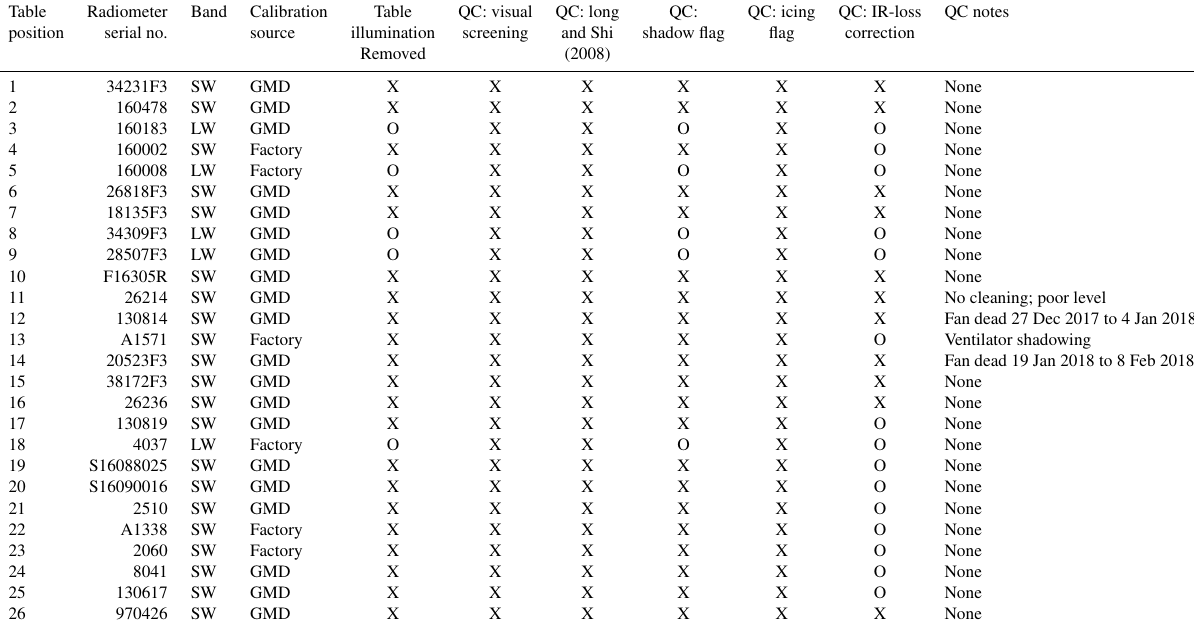
Table 1. List of quality control procedures received by D-ICE instruments. An “X” denotes that the procedure was implemented and “O” indicates that the procedure was not implemented. Table Radiometer Band Calibration Table QC: visual QC: long QC: QC: icing QC: IR-loss QC notes position serial